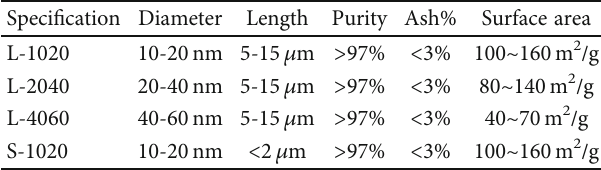
Table 1: Physical properties of the